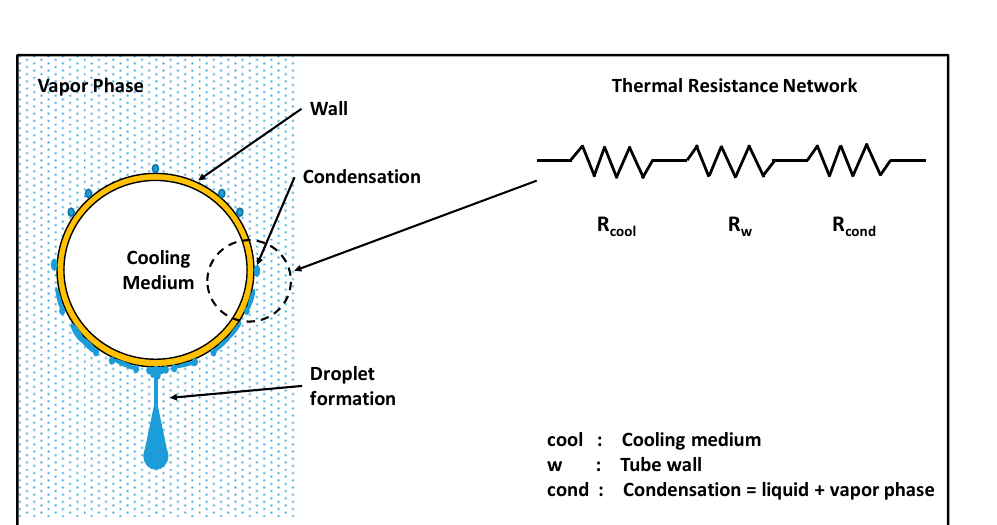
Figure 1. Condensation outside the tube surface and thermal resistance ( R ) network.